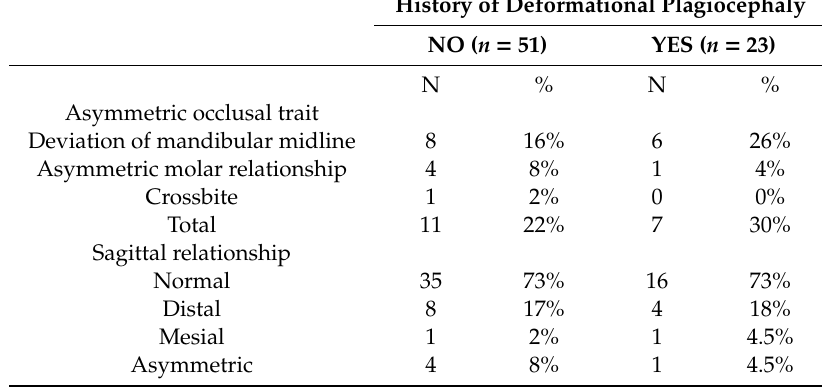
Table 6. Occlusal parameters at the age of three years old (T2), history of DP compared to no history of DP.